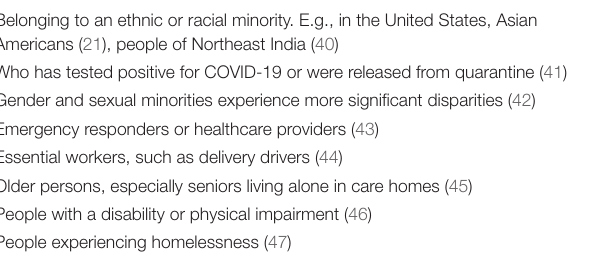
TABLE 1 | Aspects that influenced increased stigma related to COVID-19.